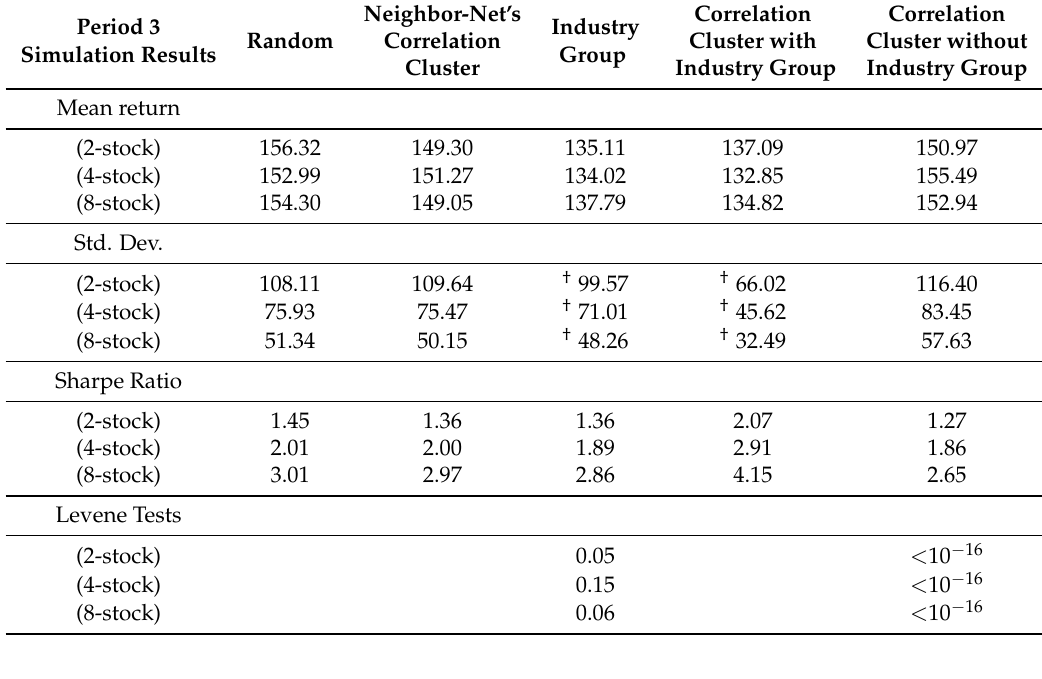
Table 3. Period 3 portfolio performances with standard deviation for three different portfolio sizes. The selection method with the lowest standard deviation is marked with an dagger ( † ).